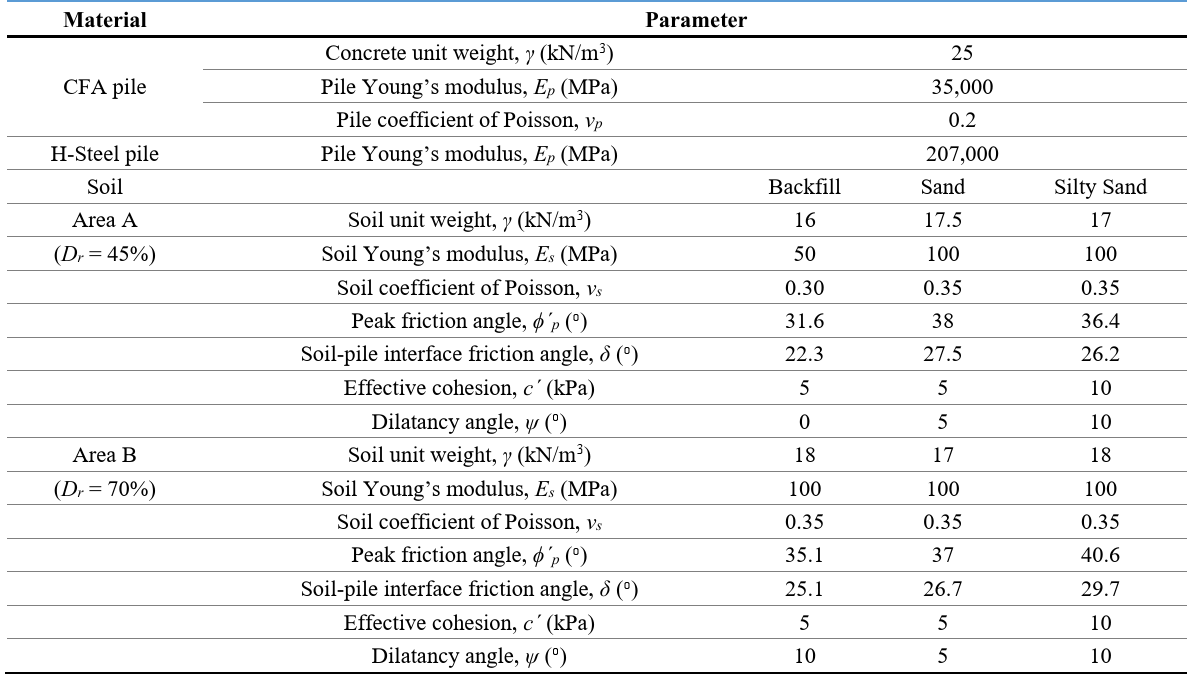
Table 2 - Material properties used in the FE